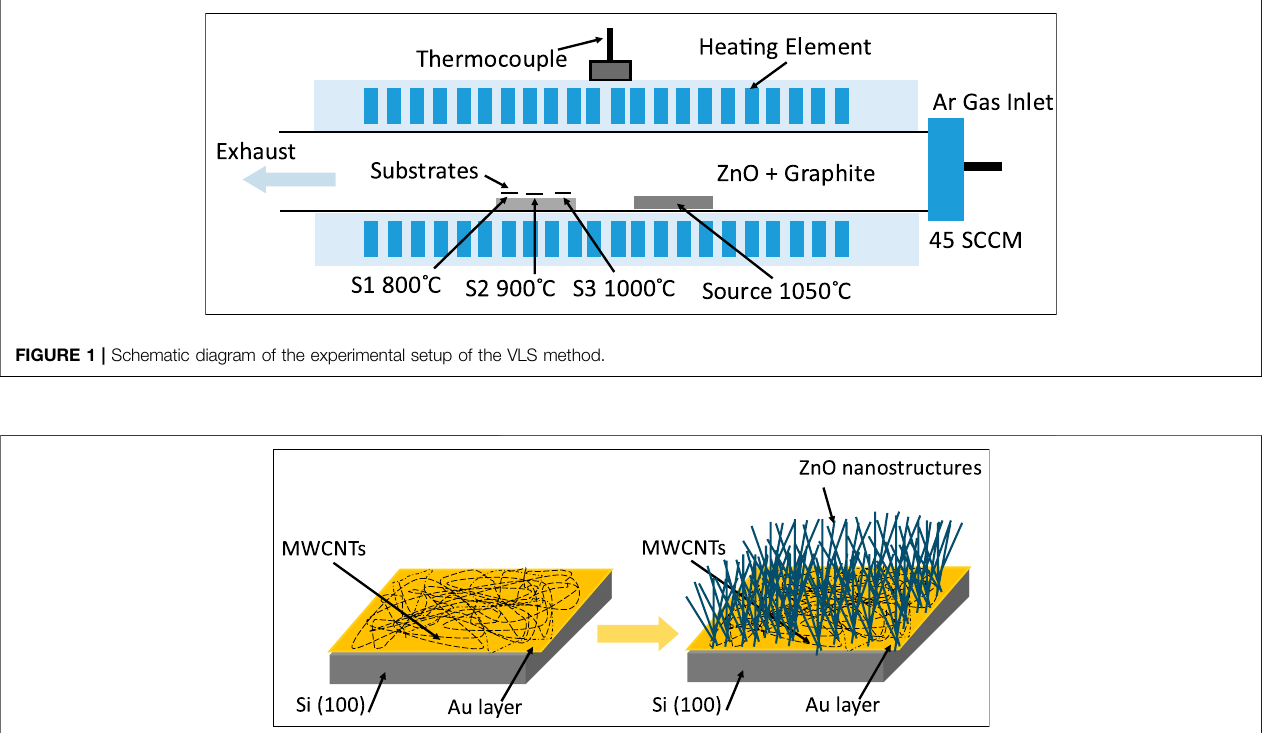
FIGURE 2 | Schematic diagram of CNTs deposited on the Au layer and growth of ZnO nanostructures by the VLS method.